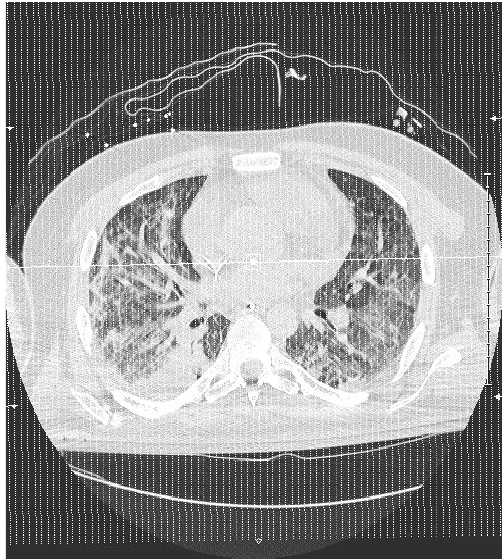
Figure 2: Chest CT